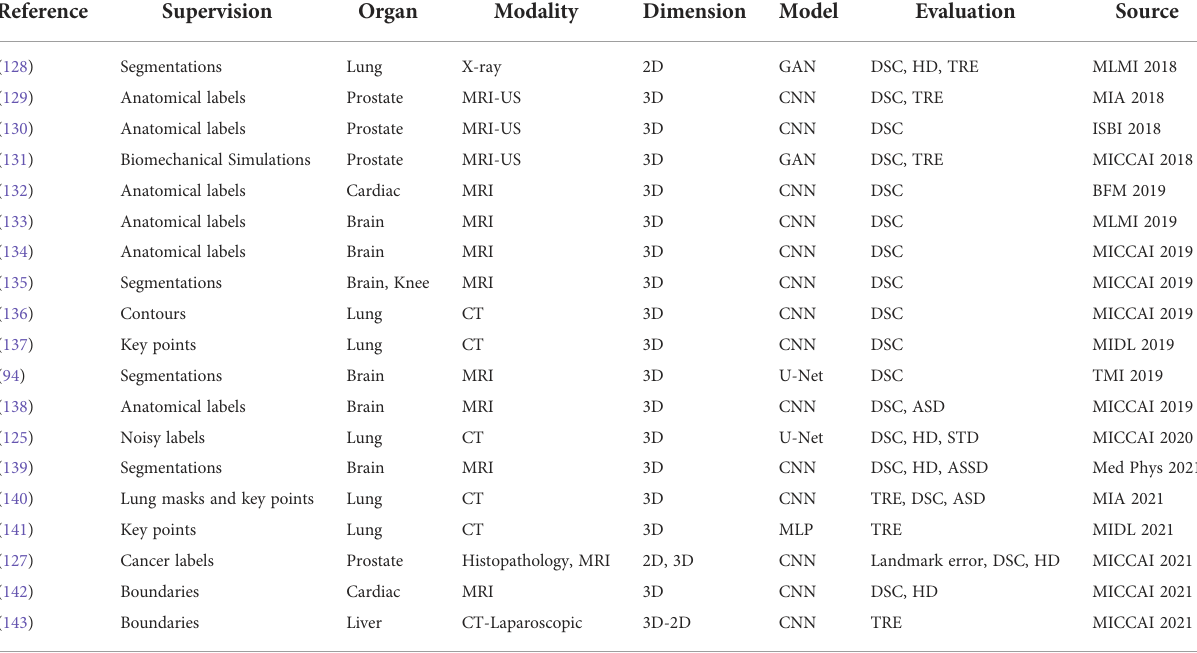
TABLE 5 Weakly supervised medical image registration methods.